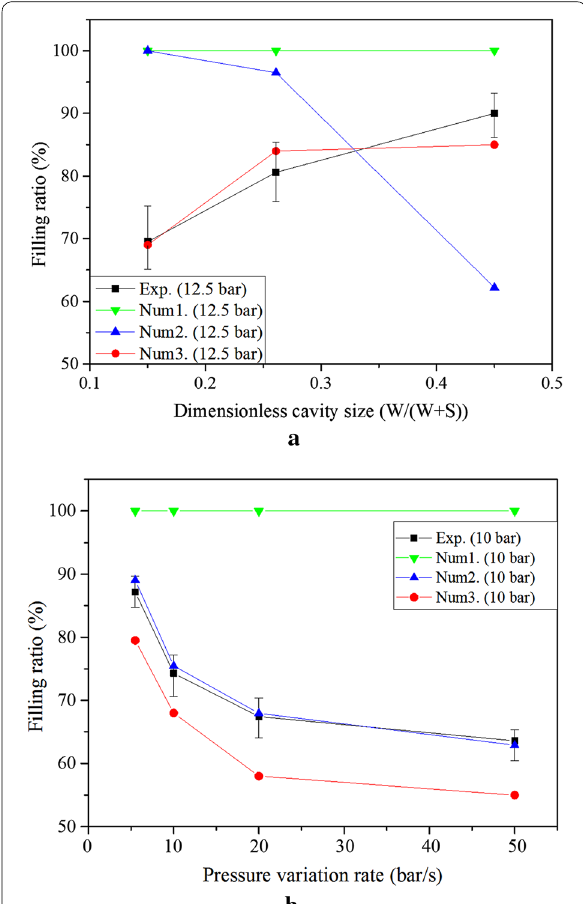
Fig. 4 Filling ratios according to the a dimensionless cavity sizes and b pressure variation rates with various numerical equations at 438